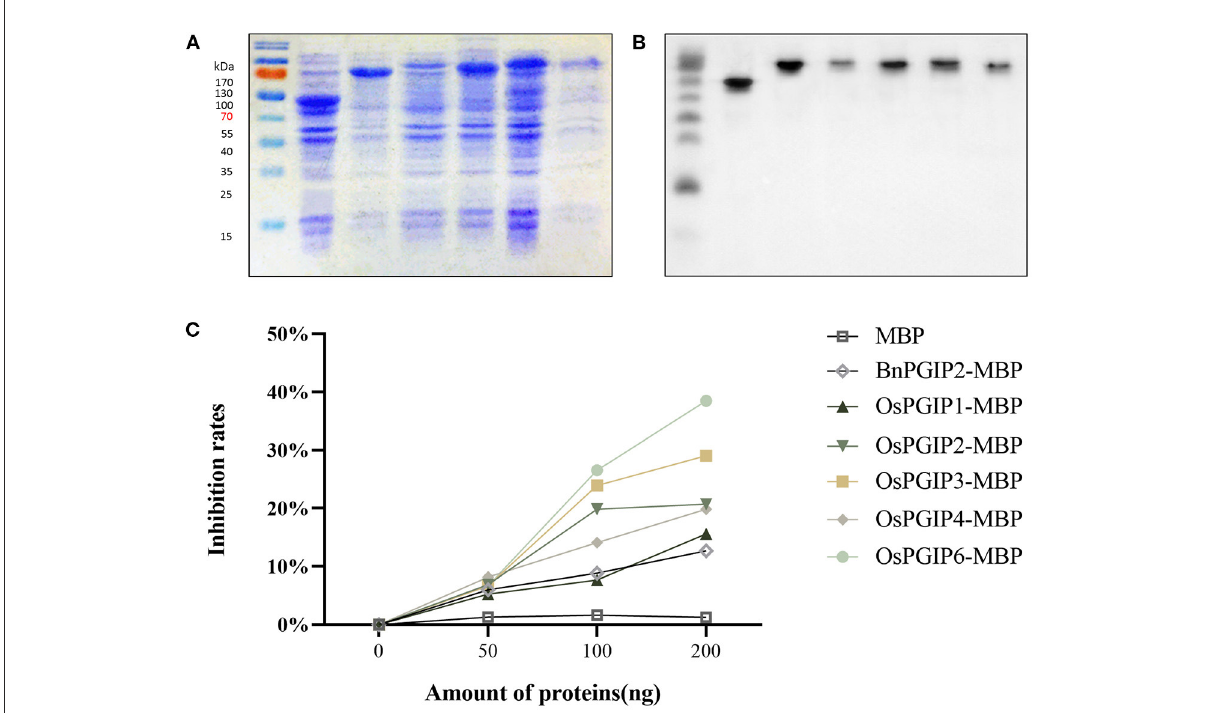
FIGURE1 OsPGIPs show PG inhibitory activity of S. sclerotiorum in vitro . (A) Supernatant protein of prokaryotic expression. Expression of OsPGIPx in E. coli. M, marker; Lane 1, 20h after IPTG inducement with MBP; Lane 2–6, 20h after IPTG inducement with OsPGIP-MBP (Lane 2: OsPGIP1-MBP; Lane 3: OsPGIP2-MBP; Lane 4: OsPGIP3-MBP; Lane 5: OsPGIP4-MBP; Lane 6: OsPGIP6-MBP). (B) The corresponding immune signals of target proteins in (A) were generated by Western blot. Western blot was performed with Anti-MBP Monoclonal Antibody (1:10,000 working dilution)